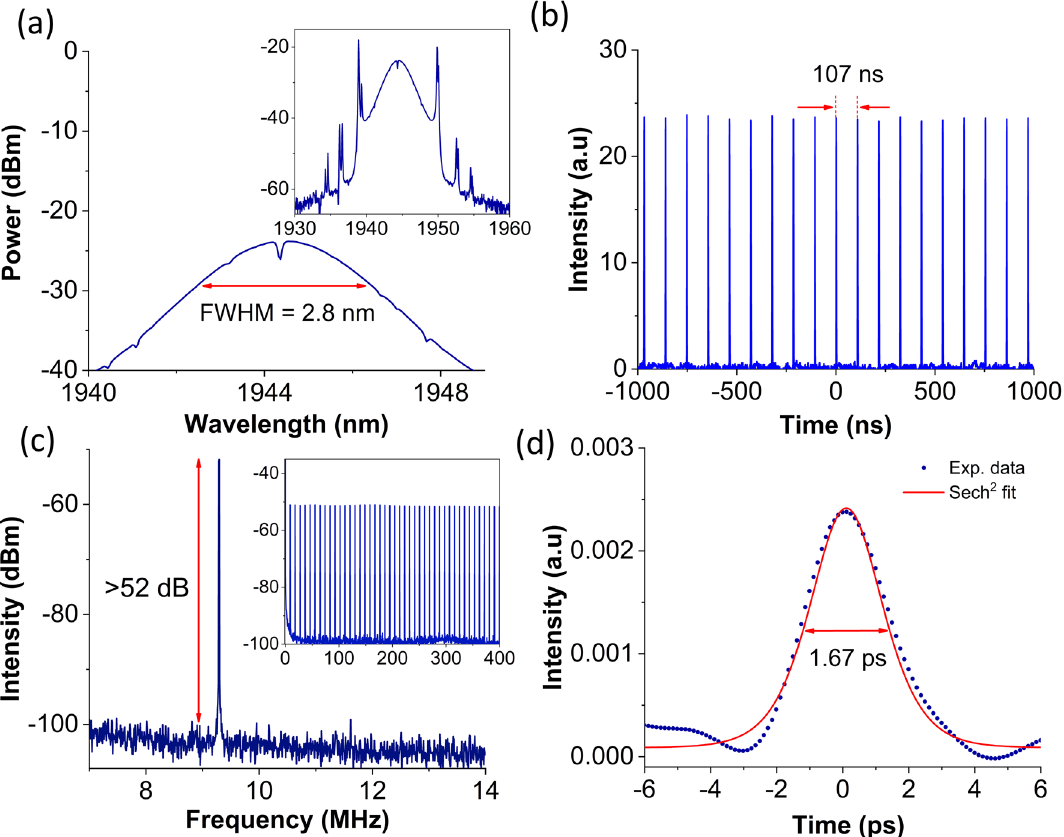
Figure 6. Mode-locked TDFL output at 476 mW. (a) Enlarged optical spectrum (Inset shows full soliton spectrum); (b) oscilloscope trace; (c) radio frequency (RF) spectrum (Inset shows the RF spectrum at a wider span range of 400 MHz); and (d) autocorrelation